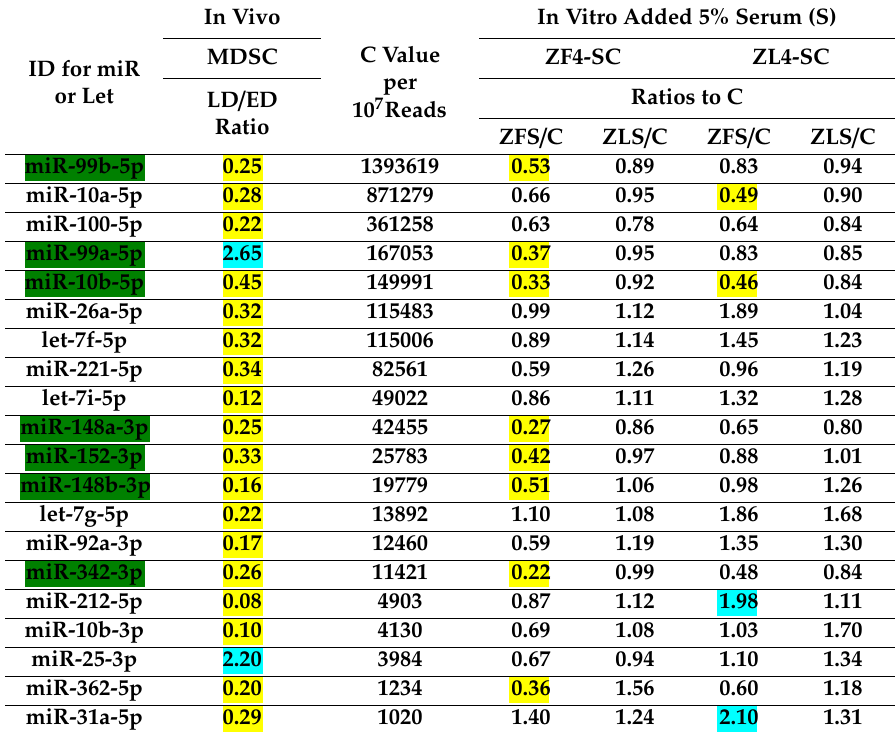
Table 3. The in vitro miR transcription changes in Table 2 were also accompanied by changes in other individual miRs (assumed unrelated to myostatin), which were a ff ected by the alterations induced in vitro by dyslipidemic